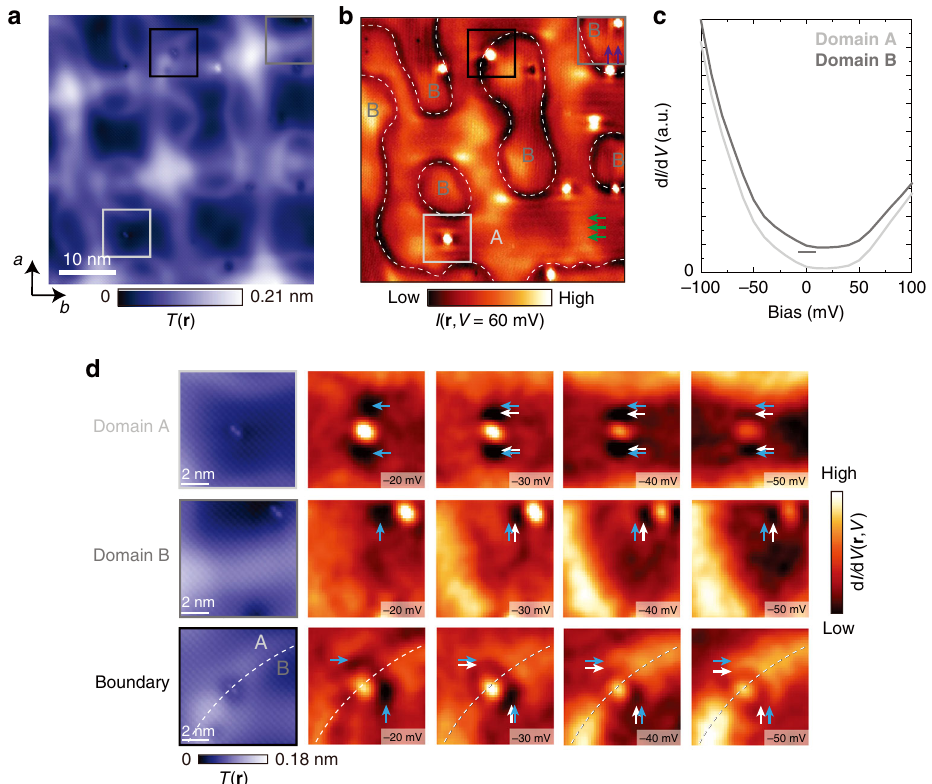
Fig. 2 Visualizing electronic nematic domains. a Atomically-resolved STM topograph T ( r ), and b tunneling current map I ( r , V = 60 mV) over an identical region, showing nematic domain boundaries denoted by white dashed lines. Horizontal charge-ordered stripes (denoted by green arrows) rotate into vertical stripes (denoted by purple arrows) across the boundaries between A and B. c Average differential conductance d I /d V spectra over nematic domains A and B, vertically offset for clarity. d Magni fi cation of the regions near three different impurities in a outlined by the light gray, dark gray and black squares, which are located in the electronic nematic domain A, B and on the boundary, respectively. The last four fi gures in each row are d I /d V( r ,V) maps encompassing each impurity, showing unidirectional dispersion from − 20 to − 50 mV. The blue and white arrows serve as guides to the eye for the dispersions. We note that the direction of this signal is not dependent on the impurity shape, as all three impurities shown are located at the equivalent Fe site. Symmetry of the electronic signal around impurities at the boundary of the two regions is broken down further, with one peak along each a -axis and b -axis, further supporting the intrinsic symmetry-broken electronic state of the system. STM setup conditions: a I set = 110 pA, V sample = − 100 mV; b I set = 110 pA, V sample = − 100 mV; d I set = 110 pA, V sample = − 100 mV, V exc = 5